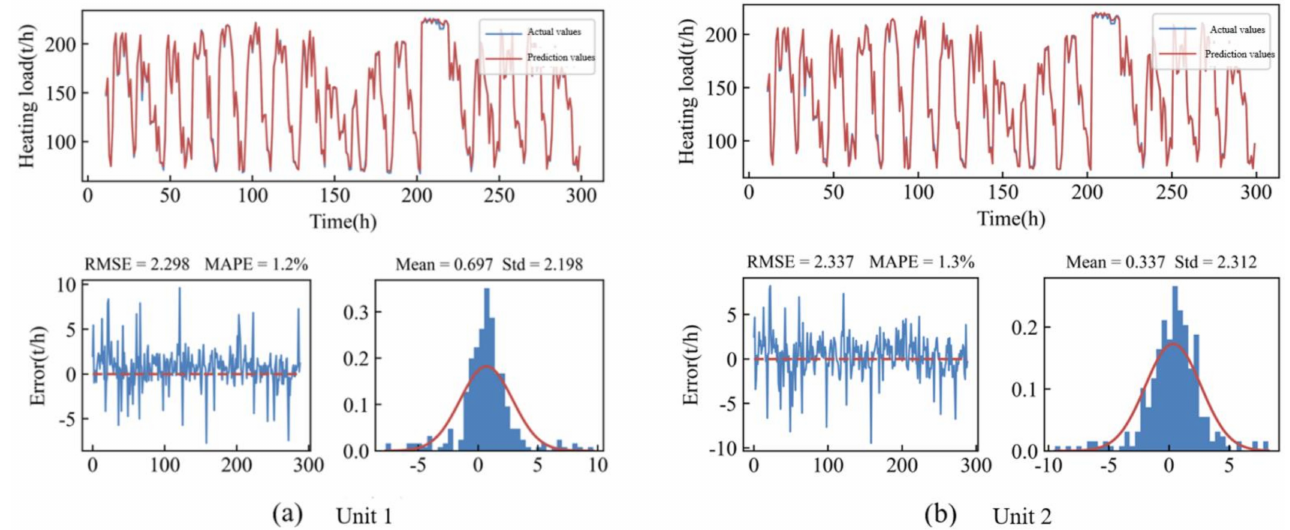
Figure 9. Forecasting and error of steam turbine: ( a ) Steam Turbine Unit No. 1; ( b ) Steam Turbine Unit No. 2. Each model of each steam turbine unit was verified ten times, and the average predic- tion error is shown in Figure 10.